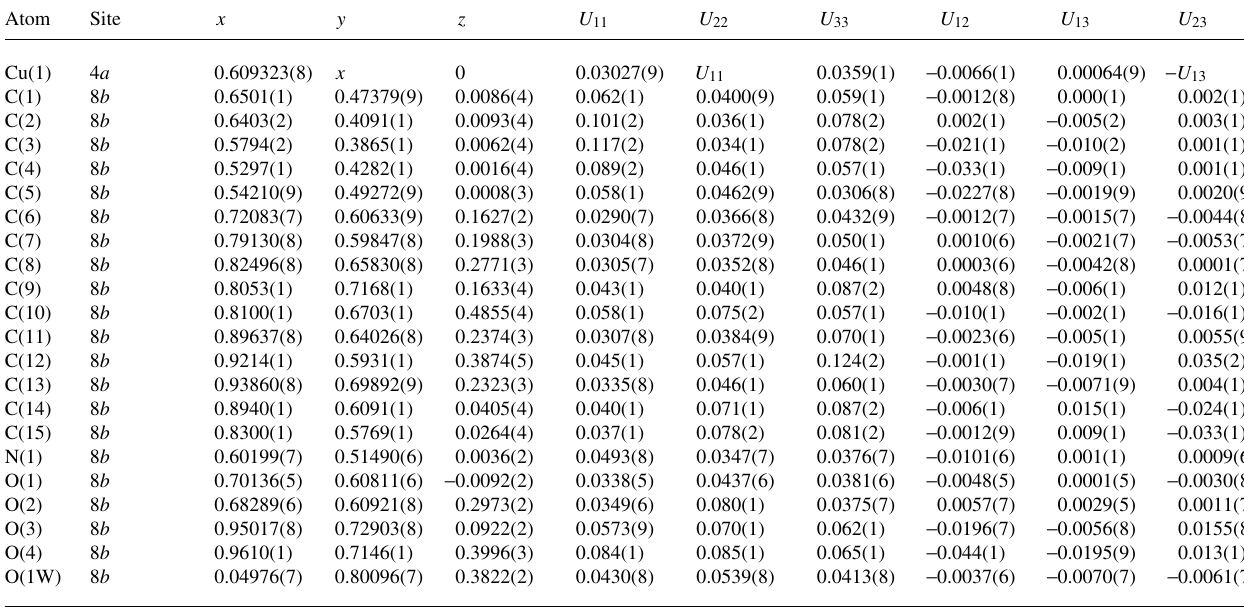
Table 3. Atomic coordinates and displacement parameters (in Å 2 )